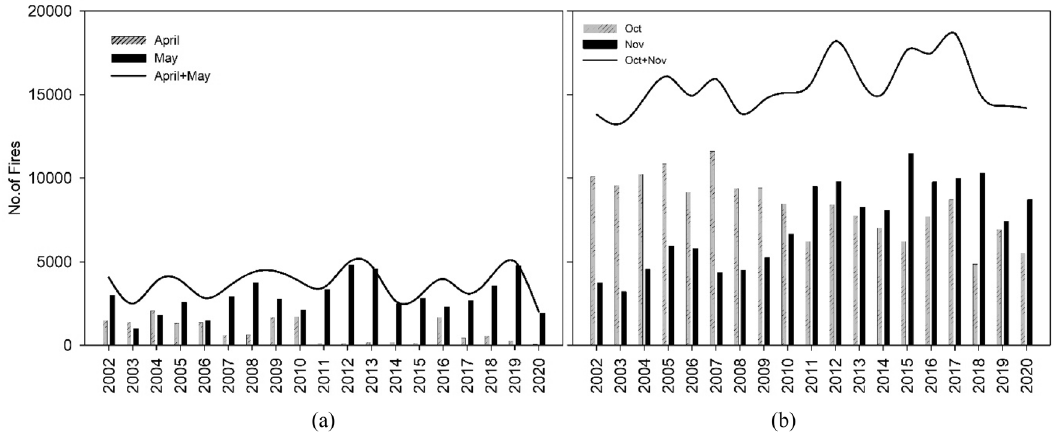
Figure 1. Time series of monthly fire counts for ( a ) PrM SB and PoM SB ( b ) during